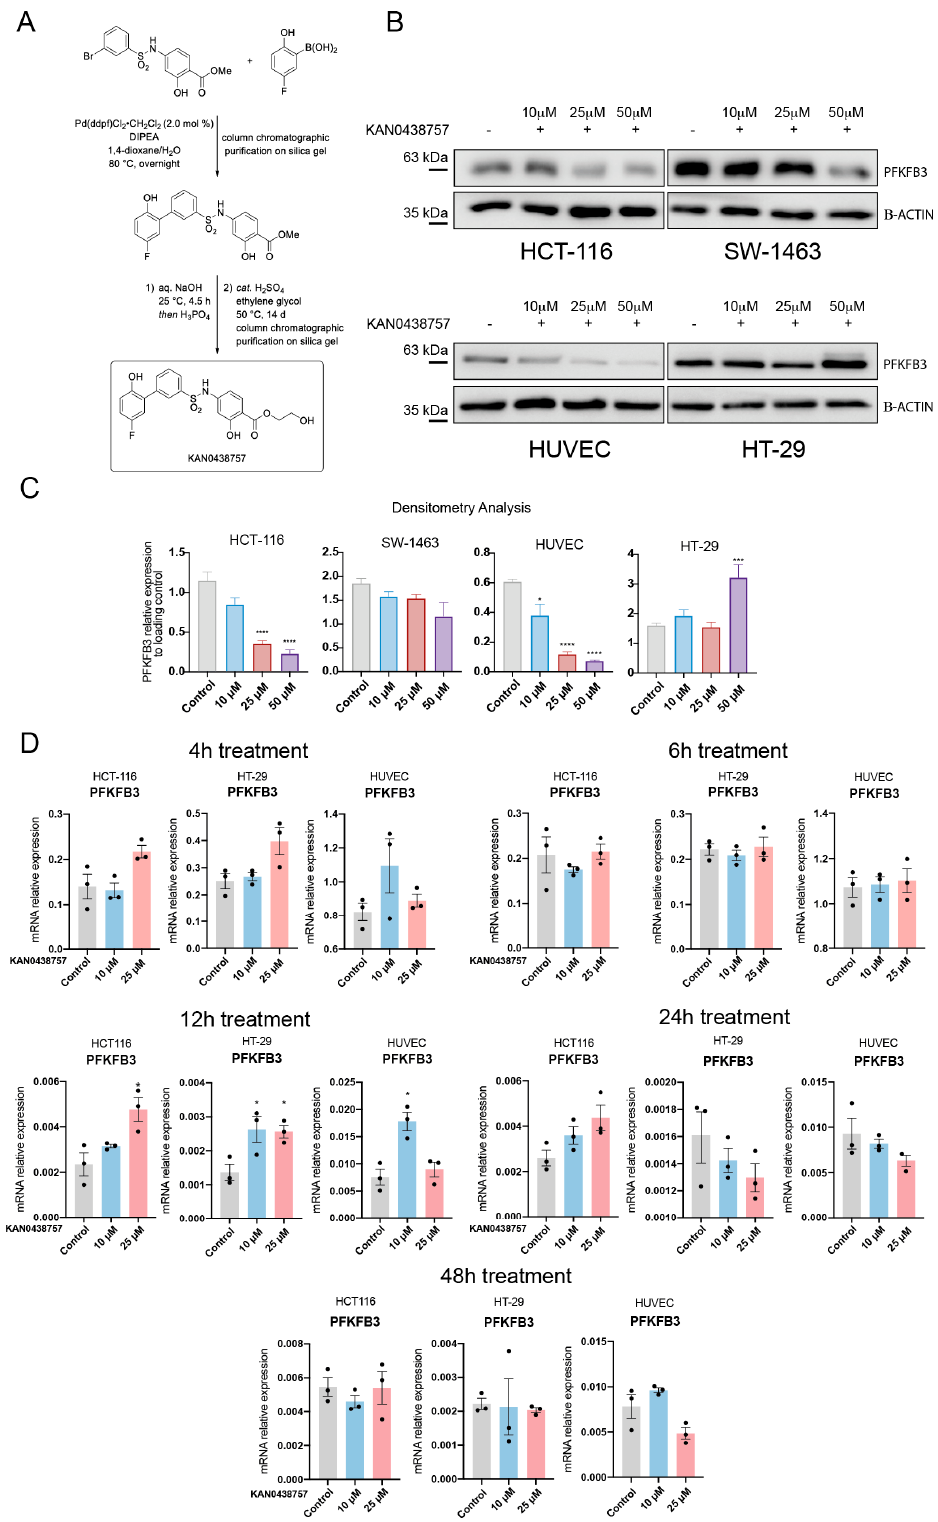
Figure 2. KAN0438757 effects on PFKFB3 expression in cancer cells and HUVECs. ( A ) KAN0438757 synthetization protocol steps. ( B ) Immunoblot. PFKFB3 inhibition in colorectal cancer cells and HUVECs upon 12 h treatment with KAN0438757. ( C ) Immunoblot relative quantification by densitometry (relative to B-ACTIN loading control). ( D ) RT-PCR analysis. Relative mRNA expression of PFKFB3 in HCT-116, HT-29 and HUVEC cells upon 4, 12, 24 and 48 h treatment with KAN0438757. Data is ± SEM. * p < 0.05, *** p < 0.001, **** p <